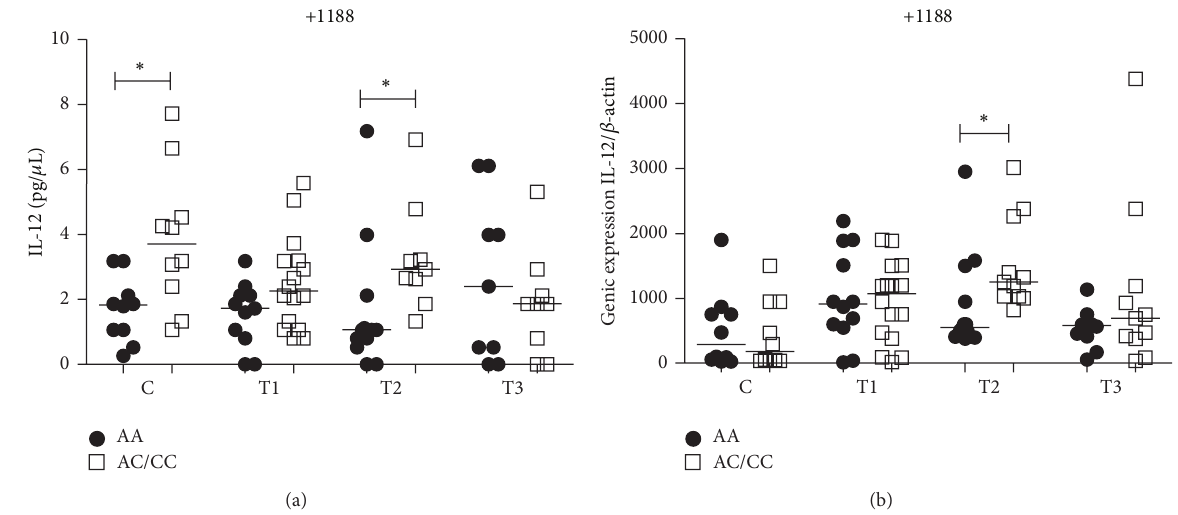
Figure 3: Influence of IL12B +1188A/C gene SNP on IL-12 plasma levels (a) and mRNA expression (b) in the control group (C) and PTB patients group at three time points of the treatment: T1 (after diagnosis and first month), T2 (three months), and T3 (six months). Data are shown as median levels. ∗ 𝑃 < 0.05